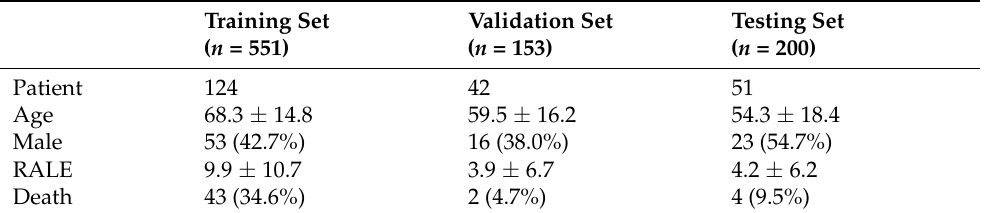
Table 2. Demographics of the dataset for carina and left hilum